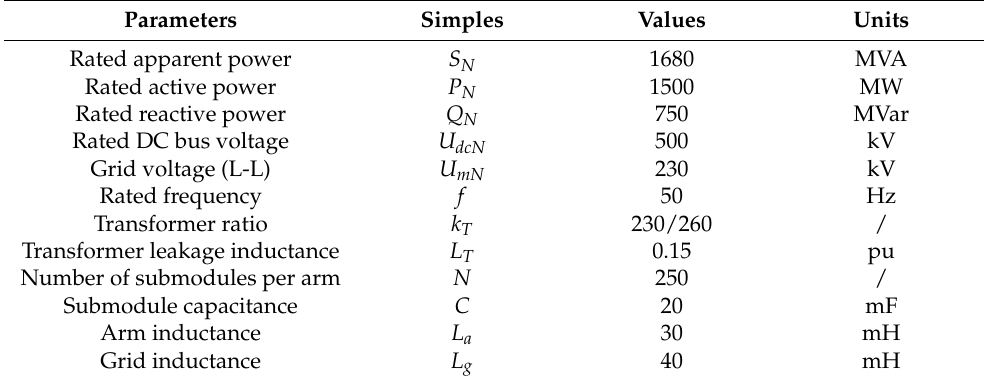
Table 1. Simulation parameters of the MMC